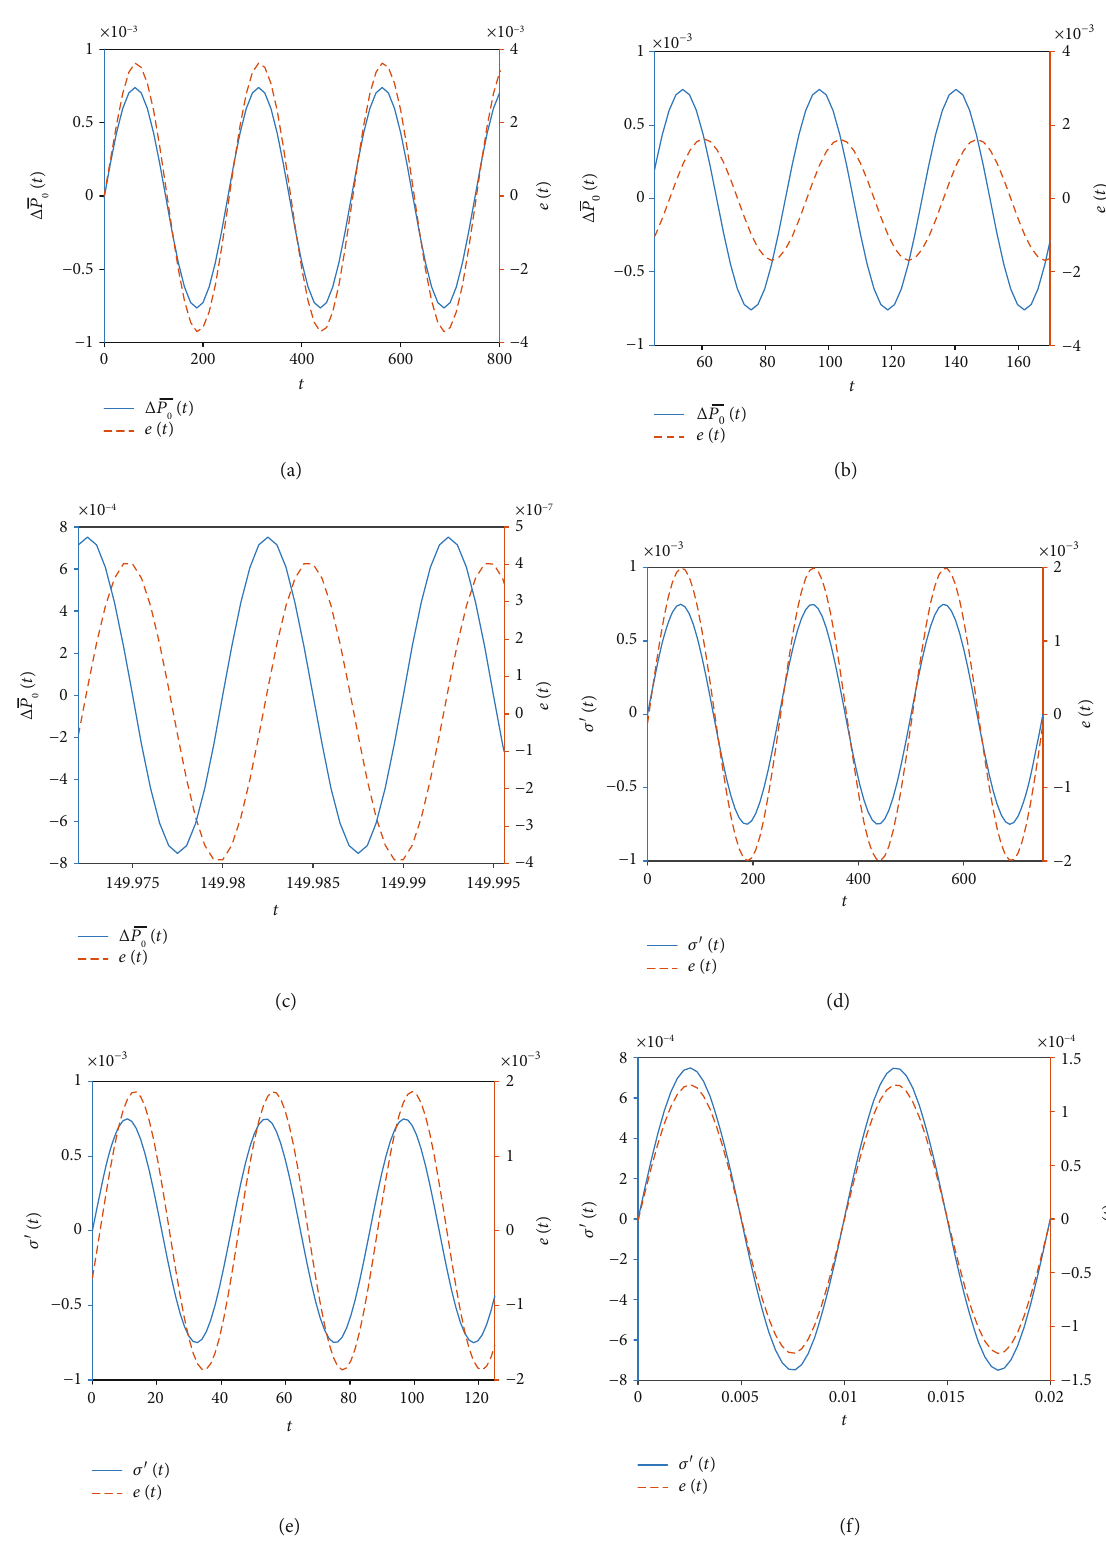
Figure 9: In fl uence of frequency, f , on system response; sinusoidal pressure input Δ (cid:1) P (dashed line on y -axis) established by the PCD equation: (a) f = 0 : 004 , (b) f = 0 : 0232 , and (c) f = 100 at conditions j (cid:1) ρ = 1 ; sinusoidal input σ ′ ð t Þ (solid line on y -axis) and strain response e ð t Þ (dashed line on y -axis) established by the SLS 0 : 1750 , and L def model regarding equation (16): (d) f = 0 : 004 , (e) f = 0 : 0232 , and (f) f = 100 at conditions σ